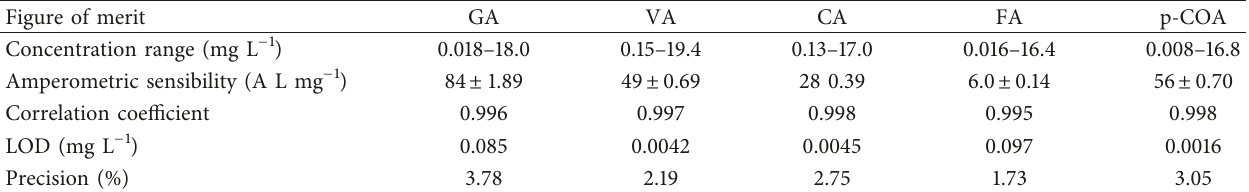
Table 2: Figures of merit for determination of polyphenols by HPLC-PAD.